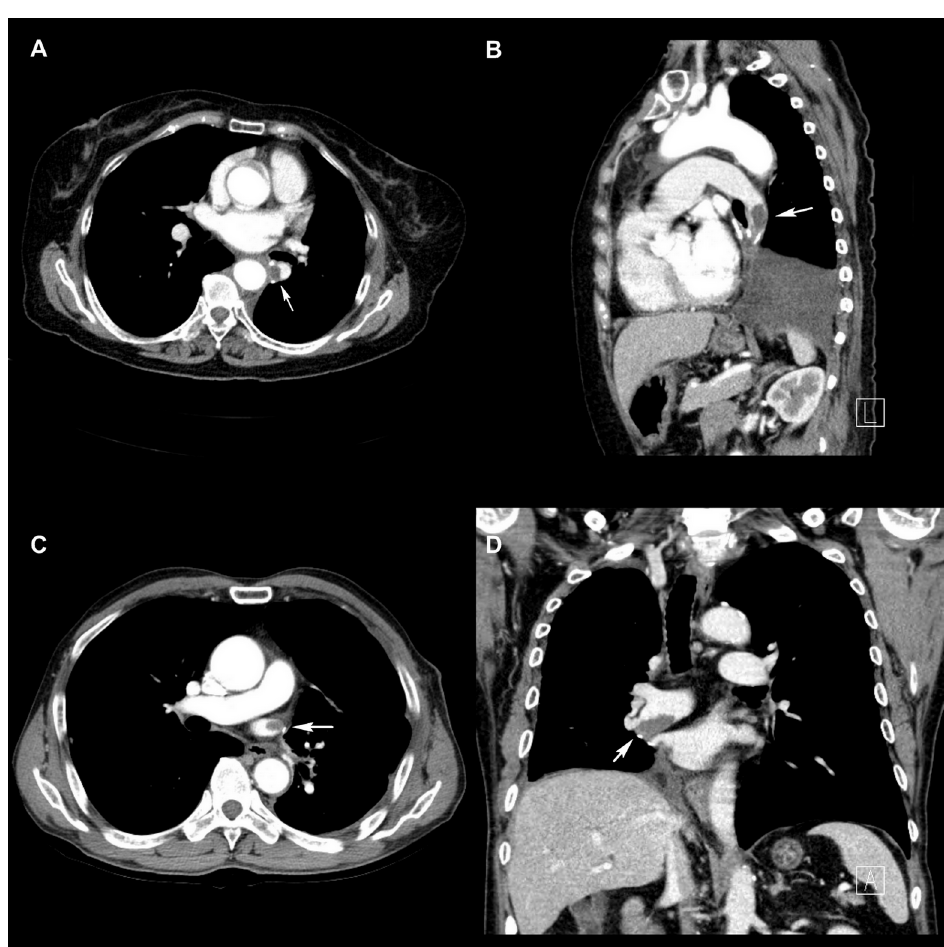
Fig 1. Various shapes and positions of vascularstump thrombi. (A) Axial image of a round and convex pulmonary artery thrombus after VATS left lower lobe lobectomy.(B) Sagittal image from the same patient, which shows the thrombus better than the axial image. (C) A small round thrombus is identified at the left superior pulmonary vein stump after left upper lobe lobectomy. (D) A large irregularthrombus identifiedat the right inferior pulmonary vein